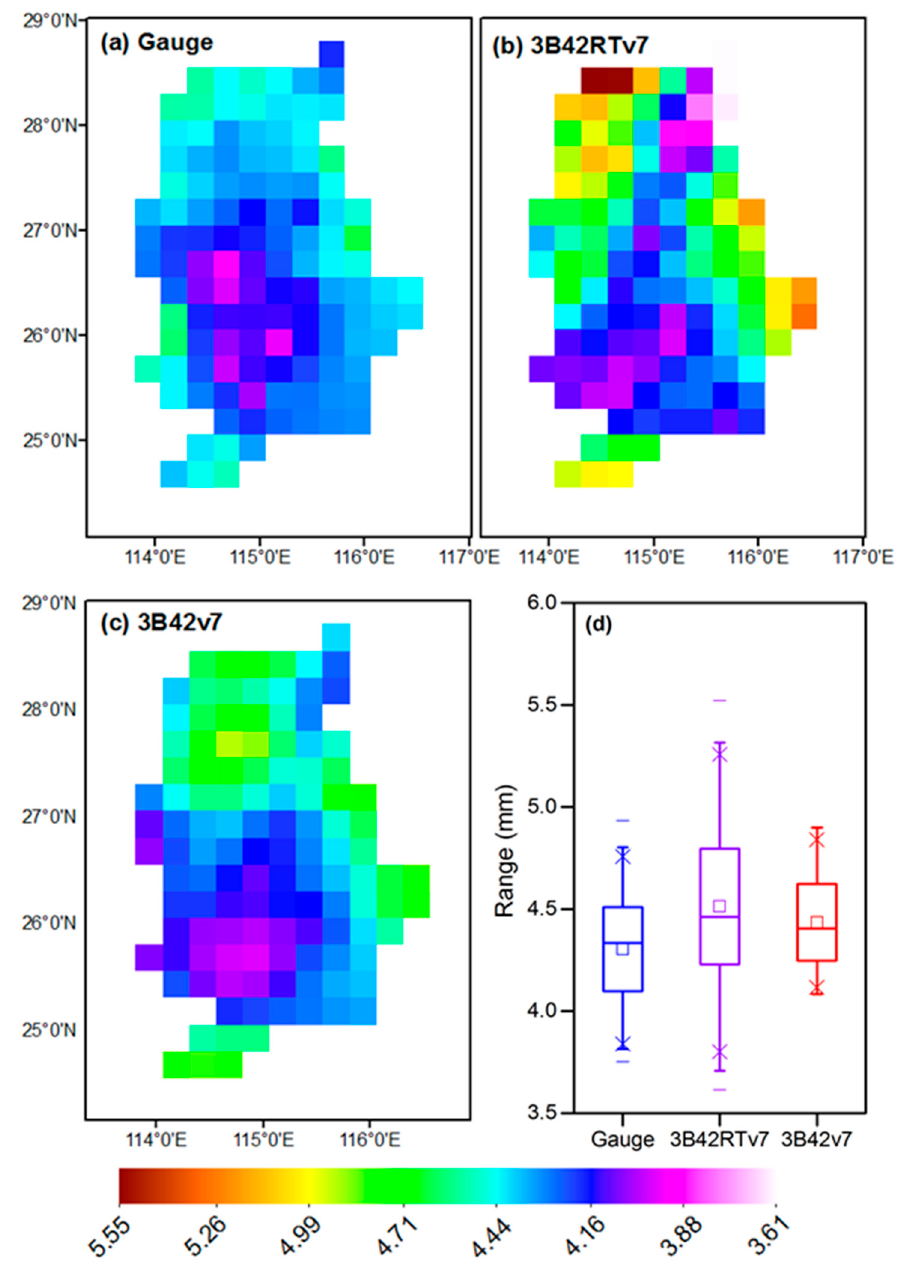
Figure 3. Spatial distributions of daily-averaged (a) interpolated gauge reference data, (b) 3B42RTv7 and (c) 3B42v7 (units in mm) with 0.25° × 0.25° spatial resolution during 14 years of study period from January 2000 to December 2013, as well as (d) boxplot summarizing the basin-averaged precipitation during the study period.